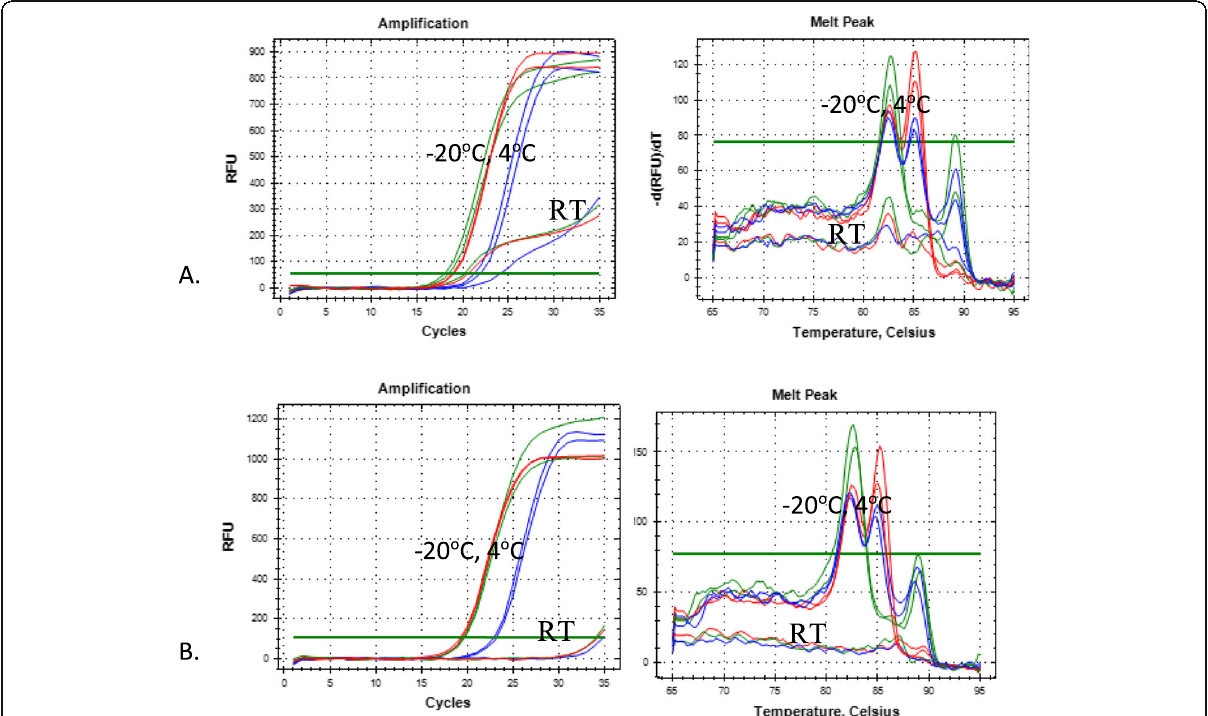
Fig. 3 Shelf-life assay of chemical used for SYBR Green I for HER-2 SNP detection during storage at room temperature (RT), 4 °C and − 20 °C. a Three-week storages. b Four-week